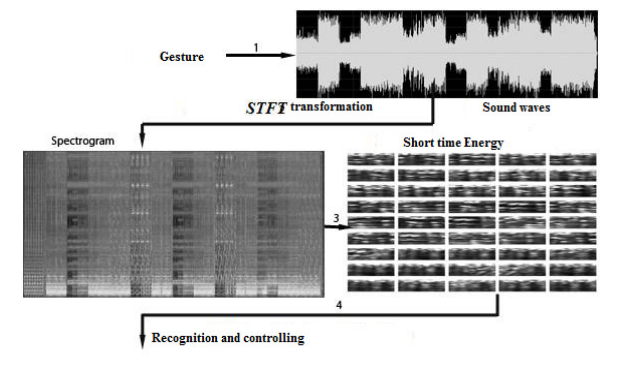
Figure 10. Describe the process of features extraction of sound waves Algorithm 1: Features extraction